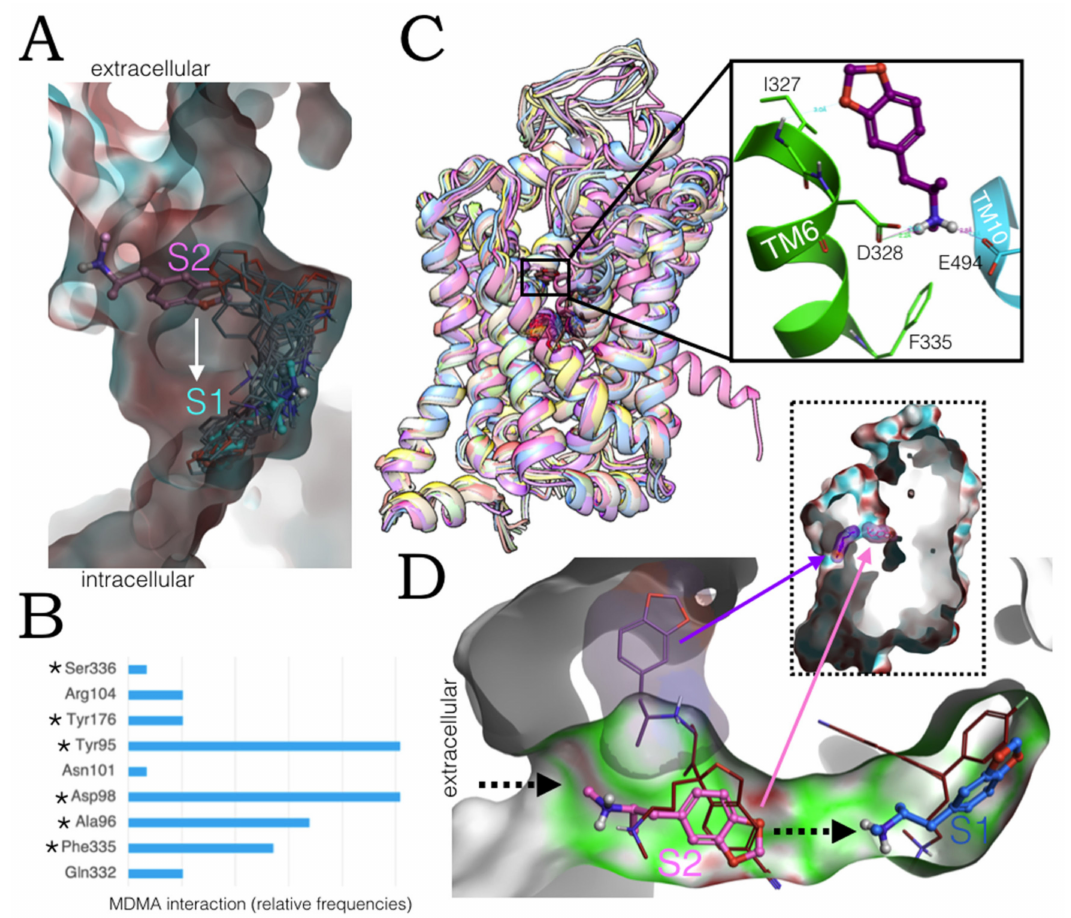
Figure 8. Ensemble binding space of MDMA on the allosteric and central site of hSERT. ( A ) Elec- trostatic surface of the MC hSERT complex model from the external vestibule S2 (in pink) to the central site (in cyan) intermediate conformations in thin sticks in grey. Surface colour scale: light blue = negative, red = positive charge. ( B ) Bonding incidences of the intermediate conformations of MDMA found on the double-bound complex after MC simulations. Asterisks mark the residues involved in the binding of MDMA to the central site. ( C ) Top 20 most energetically favoured poses from ensemble docking to all available hSERT structures. The insert shows a ‘flipped’ intermedi- ate conformation on the extracellular vestibule of S2. ( D ) Electrostatic complementarity surface of a MC double-bound hSERT/MDMA model showing an alternative location of MDMA at S2 with a ‘5-HT-like orientation’. Intact escitalopram locations are shown in thinner dark red